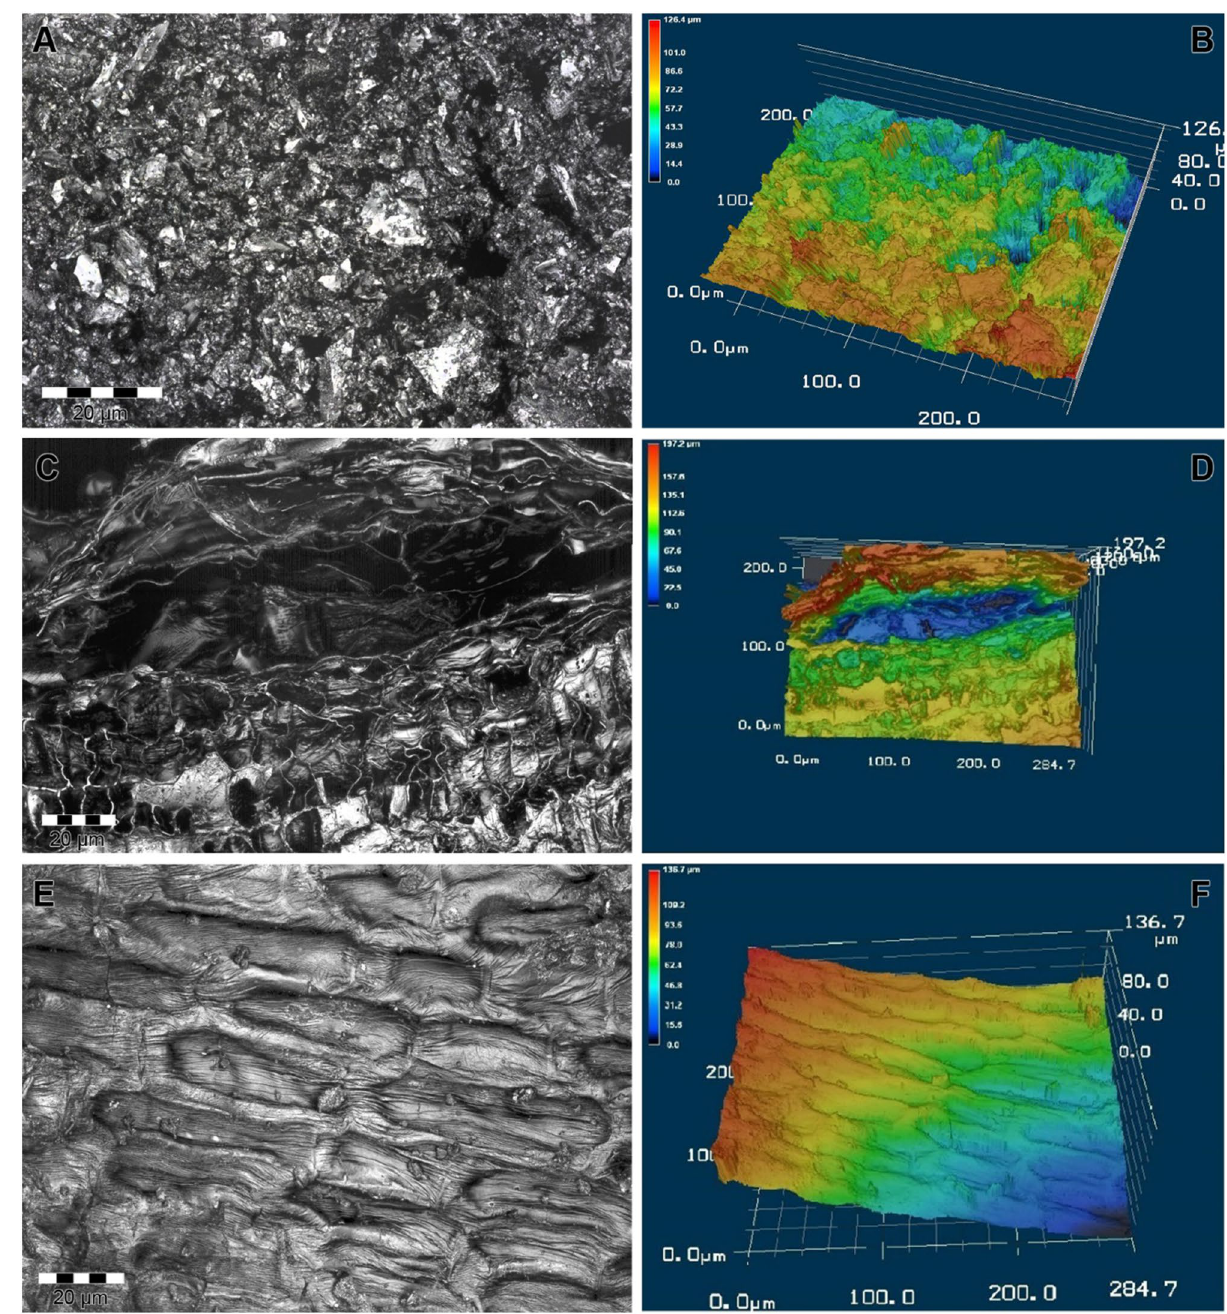
Figure 3. SEM images of different biochars: ( A ) wood; ( B ) 3D model of the wood biochar surface; ( C ) sunflower husks; ( D ) 3D model of sunflower husk- biochar surface; ( E ) rice husks; ( F ) 3D model of the surface of rice husks.